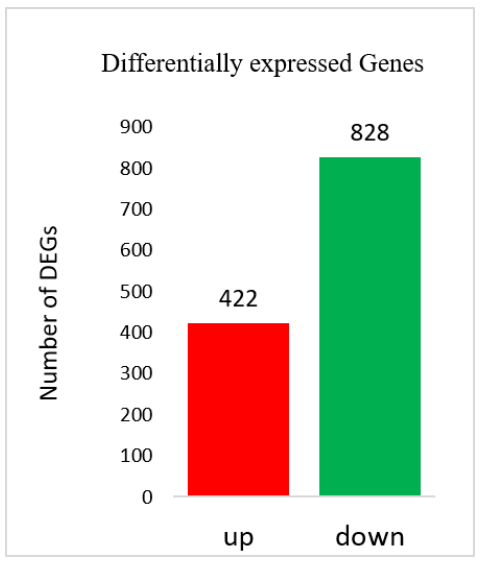
Figure 3. Differentially expressed genes (DEGs) identified between the two accessions.